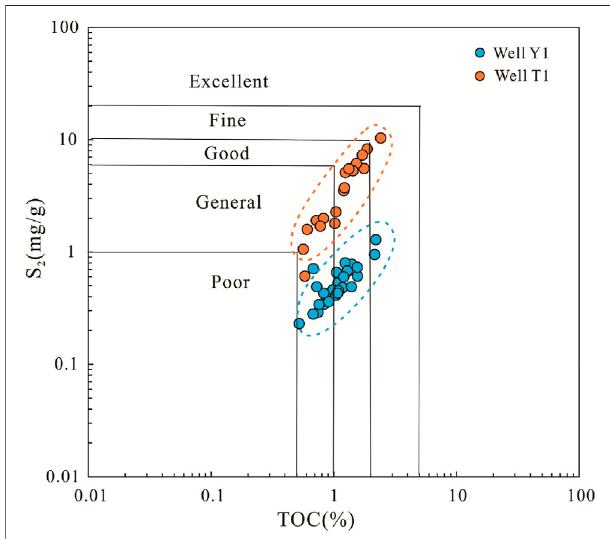
FIGURE 3 | The relationship between TOC and S 2 content of the J 1 da shale